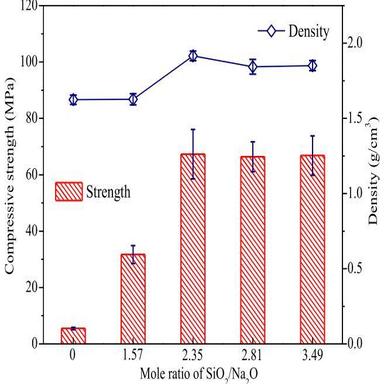
Compressive strength and density of alkaline activated IBA-glass.